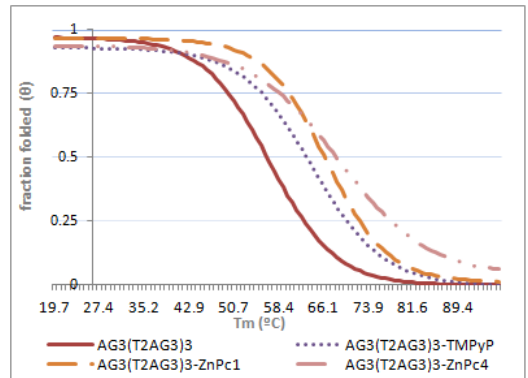
Figure 11. CD melting profiles obtained for GQ unimolecular AG 3 (T 2 AG 3 ) 3 in the absence or in the presence of ZnPc1, ZnPc4 and TMPyP. Table 5. CD melting temperatures (n=3).